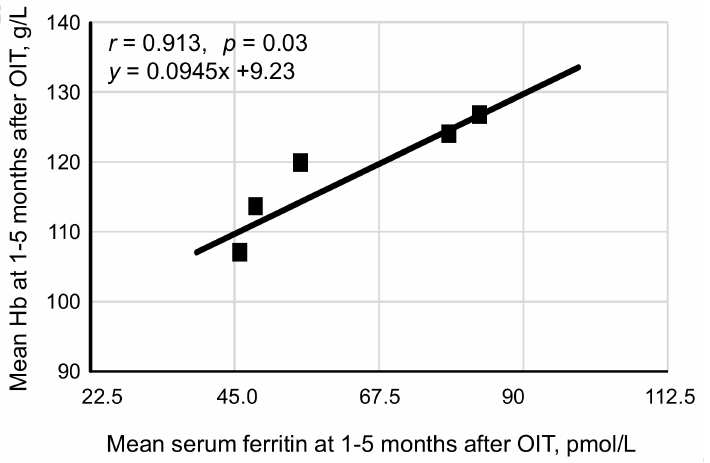
Figure 5. Correlation of Hb and serum ferritin between 1 and 5 months after OIT in OIT-responders. Ccorrelation between the levels of Hb and serum ferritin was analyzed in 39 OIT-responders using mean values for Hb and serum ferritin at every month obtained from OIT-responders as a whole. The levels of Hb were positively correlated with serum levels of ferritin till 5 months after OIT in 39 OIT-responders. The correlation equation calculated by Pearson’s correlation coefficient test was y = 0.0945x + 9.23, where y = Hb: x = serum